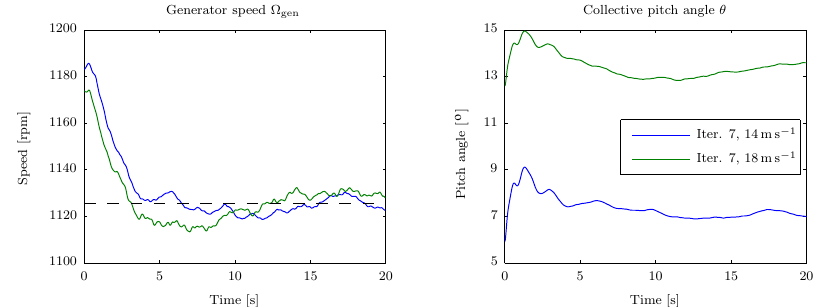
Figure 18. Comparison of the CPC step responses for 14 and 18ms − 1 with 4% turbulence intensity during the seventh